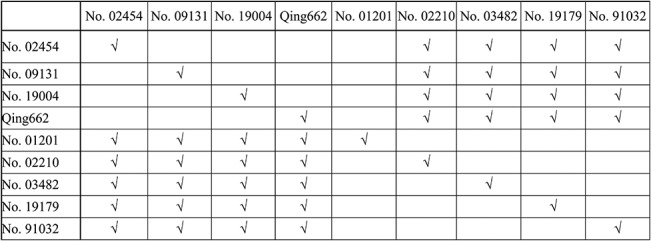
Treatment combinations for the maternal study.“√” represents the combination emasculation hybrid treatment.